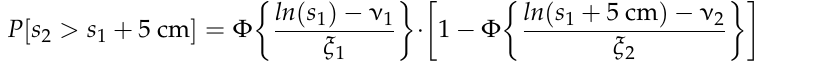
Figure 8. Loaded by the main building (dashed line) and unloaded, free field (solid line) settlements versus peak ground acceleration at the critical section of the emergency service water piping.